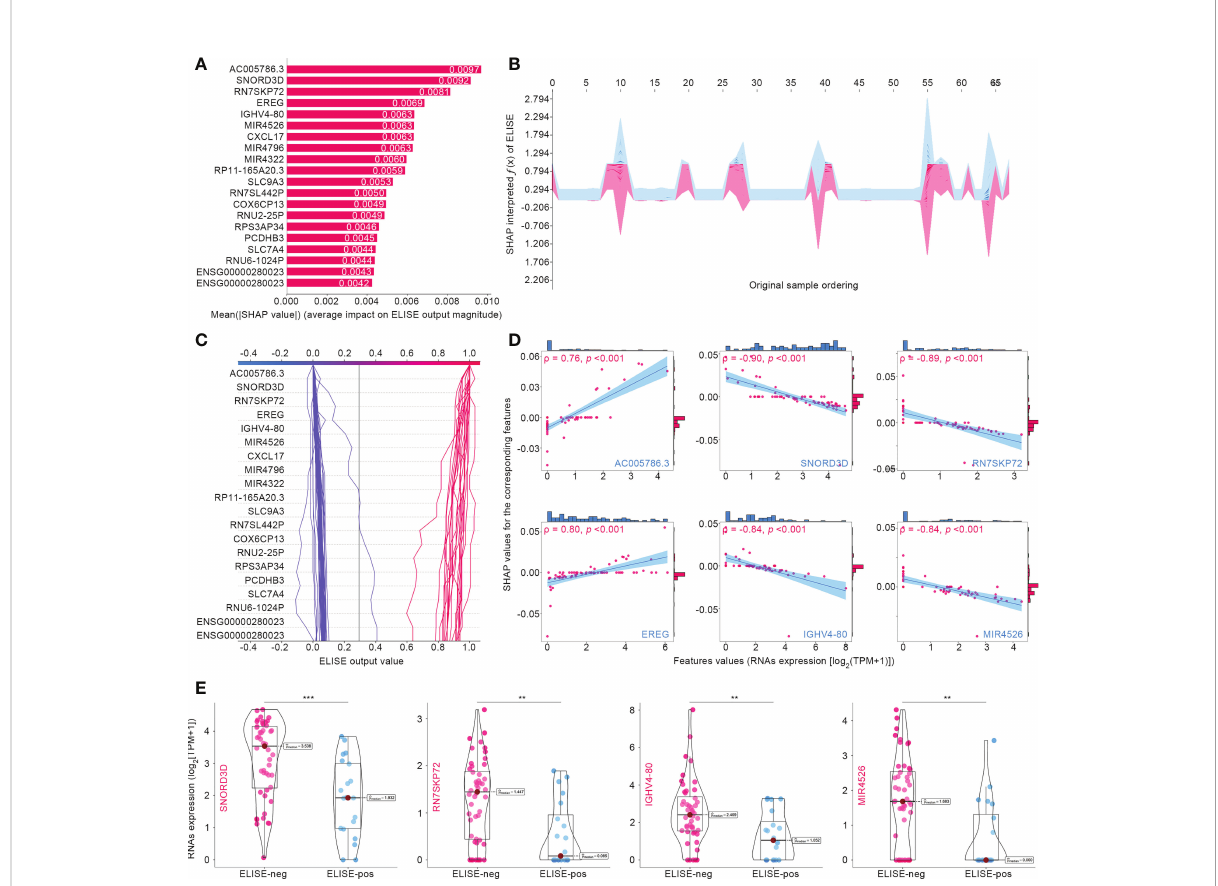
FIGURE 3 Interpreting ELISE in EACs. (A) SHAP summary plot ranked and presented the top 20 important features. (B, C) exhibited how ELISE makes the global and individual prediction. (D) Dependent plot indicated the affection directions of top 6 features. (E) Many top important features identi fi ed by SHAP presented differential expression pro fi les between ELISE-neg and ELISE-pos subtypes. The symbols ** represents p < 0.01, and *** represents p <